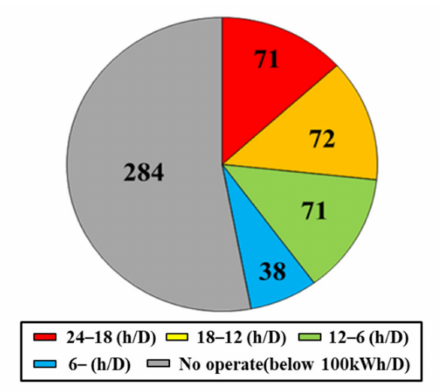
Figure 8. Continuous operation situation (from 18 October 2016 to 13 July 2017). Reprint with permission; JSME, 2020